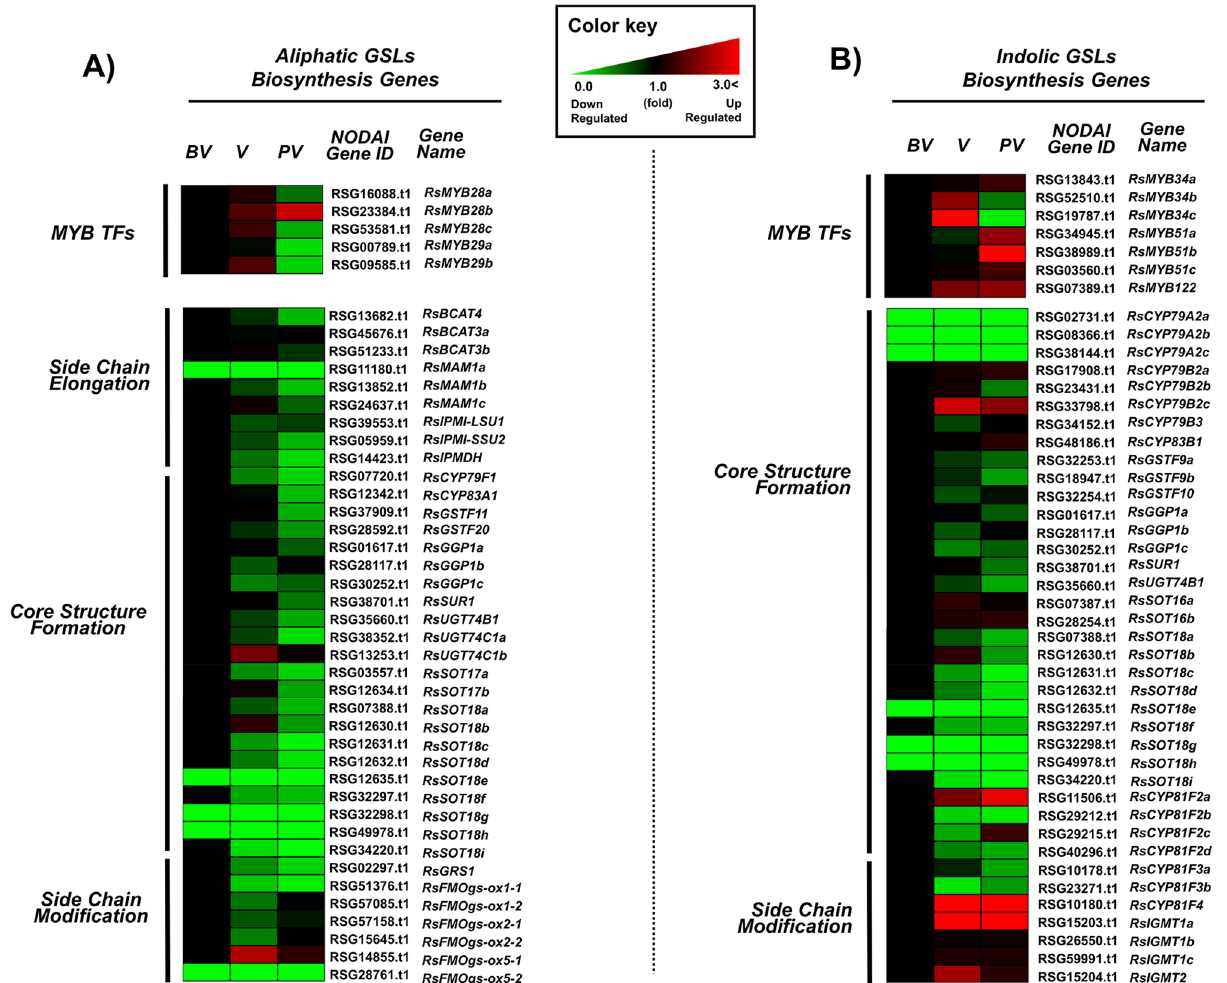
Figure 6. Heatmap of the transcriptional profiles of aliphatic ( A ) and indolic ( B ) GSLs pathway genes in radish ( R. sativus ) at different vernalization time points ( BV before vernalization, V vernalization, AV after vernalization). The transcript value of each gene was normalized in comparison to the value before-vernalization (BV), which was set as